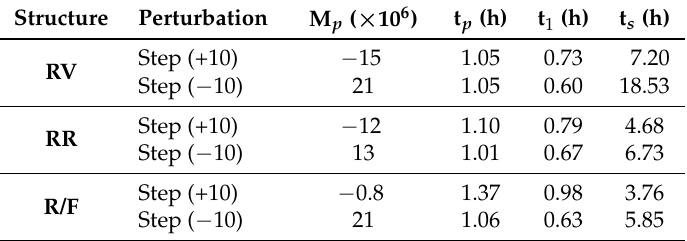
Table 8. Characteristics of the controller response—case of feed composition perturbation.